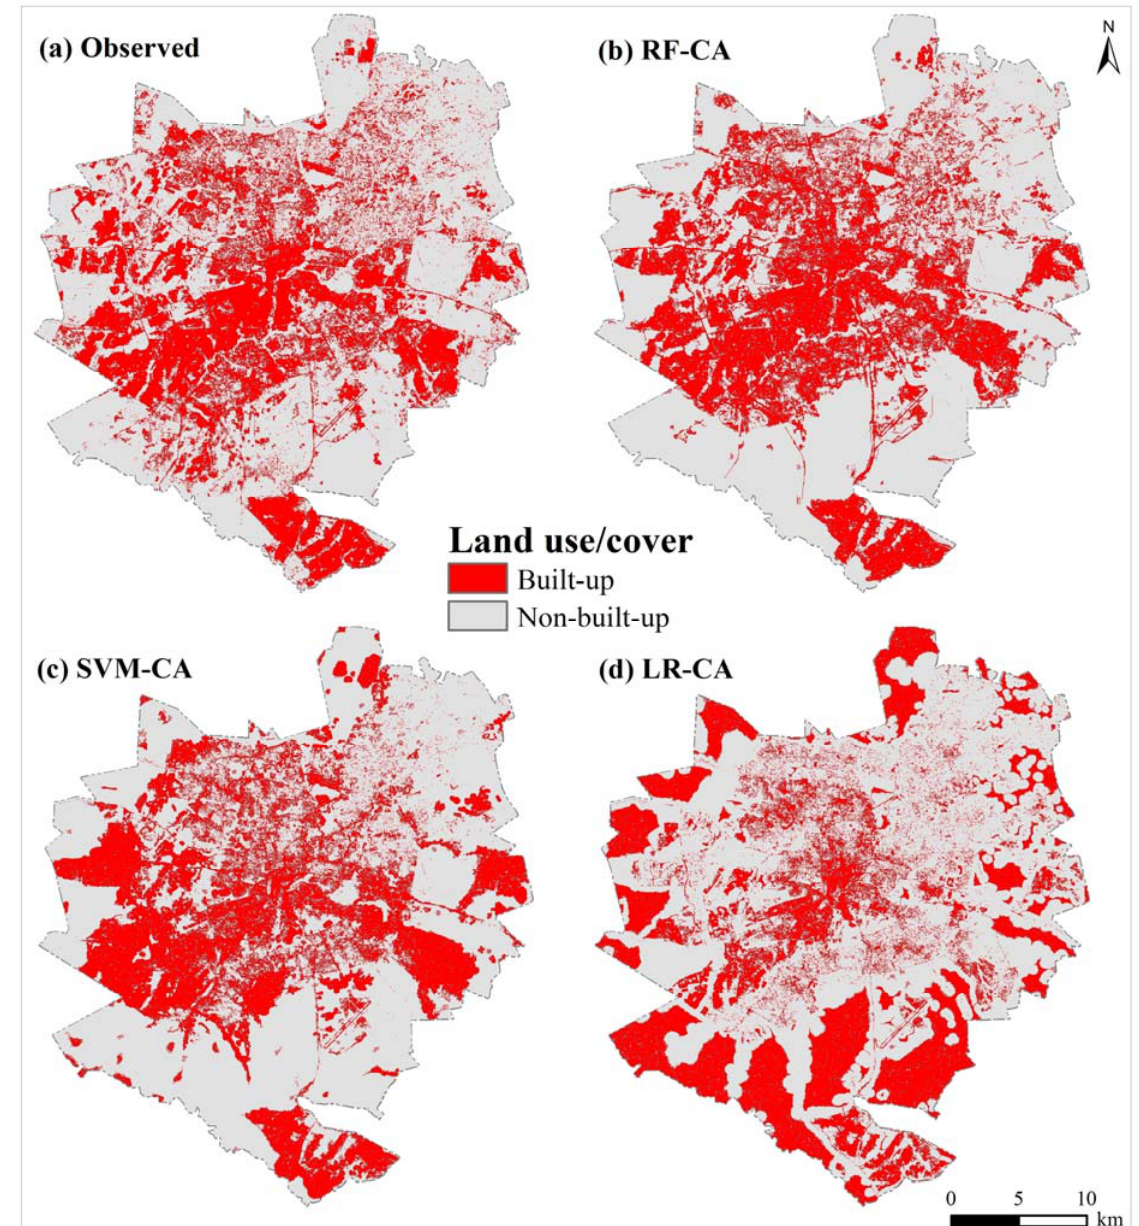
Figure 7. Comparison of observed versus simulated land use/cover maps for 2013: ( a ) observed land use/cover map; ( b ) RF-CA simulated land use/cover map; ( c ) SVM-CA simulated land use/cover map; and ( d ) LR-CA simulated land use/cover